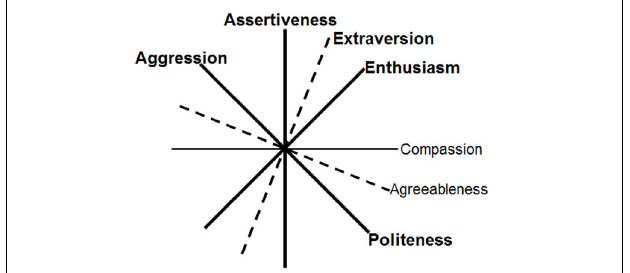
FIGURE 2 | Angular relations among the aspects of Extraversion and Agreeableness correspond to the interpersonal circumplex (DeYoung et al., 2013a). Aggression characterizes the low pole of Politeness. Traits in bold are hypothesized to be influenced by